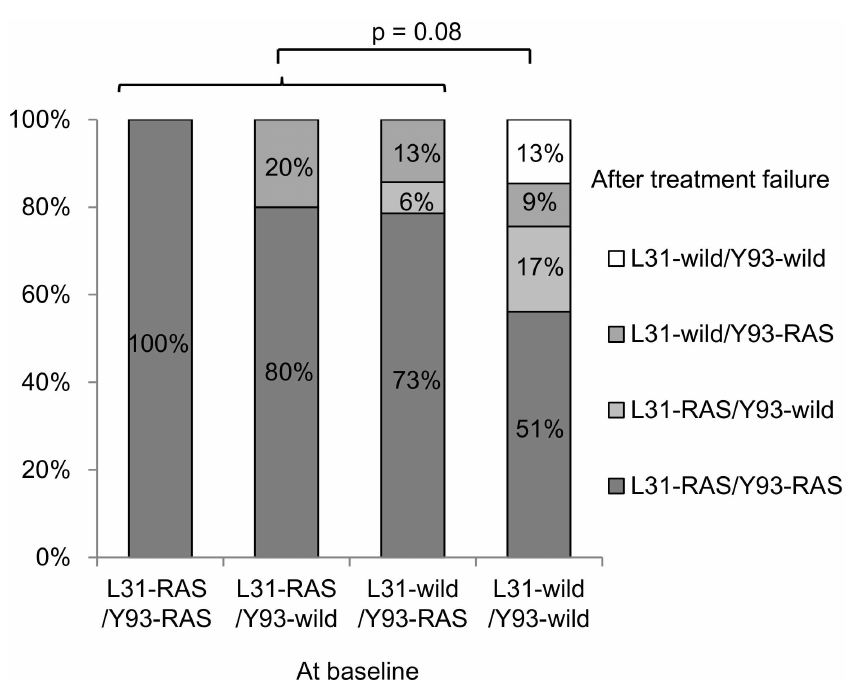
Fig 3. Prevalenceof signature RASs in NS5A after treatment failure in terms of baseline RASs. The prevalence of signature RAS at L31 and Y93 in NS5A after treatment failure in patients stratified by presence of baselineRASs. Even in patients without L31/Y93RAS at baseline,dual RAS at L31 plus Y93 emerged after treatment failure. The prevalenceof dual RASs was not significantlydifferent between patients with and without RASs at baseline(p =